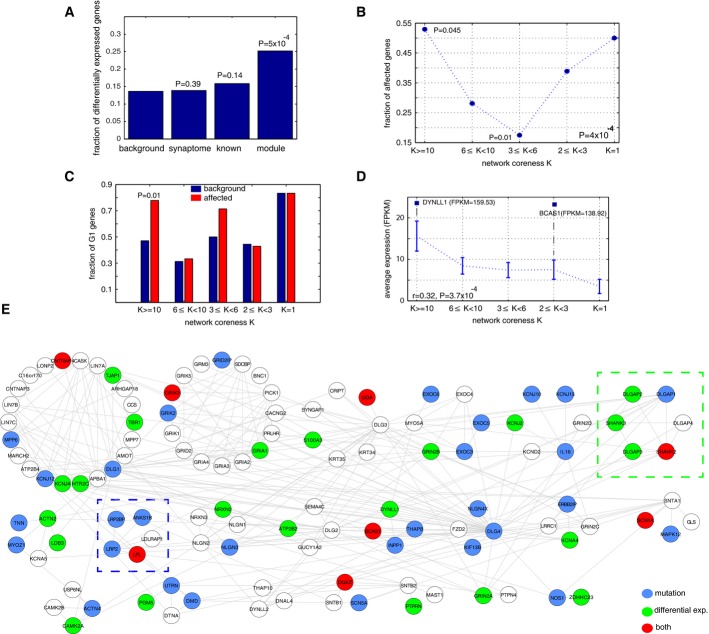
Integrative analysis of the genetic alteration in this study
Enrichment of the differentially expressed genes in module #13. RNA-sequencing of the corpus callosum of autism patients and their matched controls. Enrichment was not observed for the genes in the human synaptome or the collection of known autism genes (excluding genes in this module). Statistical significance was determined by hypergeometric test.

The mutation pattern of the genes from the innermost layers of the interaction network (K ≥ 10) to the periphery layer (K = 1). Genes in the central and periphery layers in this module are more likely to be affected, while the trend cannot be observed in 10,000 random simulations. For individual bins, significant enrichment and depletion were observed in the central layers (K ≥ 10) and the intermediate layers (3 ≤ K < 6), respectively. Statistical significance of the enrichment was determined by hypergeometric test. 10,000 random permutations were performed to determine the statistical significance of the curve.

Compositional bias of the mutated genes in central layers. The mutated genes in central layers are more biased toward the corpus callosum-specific subcomponent; this trend is not observed in background or other mutated genes with varying degree of K. Statistical significance of the enrichment was determined by hypergeometric test.

Positive correlation between network coreness and gene expression in the corpus callosum. RNA-sequencing of the corpus callosum of six non-autistic individuals revealed a positive correlation, suggesting the central layers may play critical roles in the corpus callosum. Two outlier genes, DYNLL1 and BCAS1, are separately labeled due to their extreme expression in this tissue. The correlation coefficient r and its statistical significance were computed using Spearman's correlation.

Predicted sub-complexes within this module. Genes in this module are topologically clustered to form sub-complexes, with the significantly mutated genes labeled in blue, mis-expressed genes in the corpus callosum labeled in green, and both in red. Two clusters, #6 for SHANK-DLGAP complexes and #6 for LRP2, and its binding partners, are enriched for the mis-expressed or mutated genes, respectively. Statistical significance of the enrichment was determined by hypergeometric test.